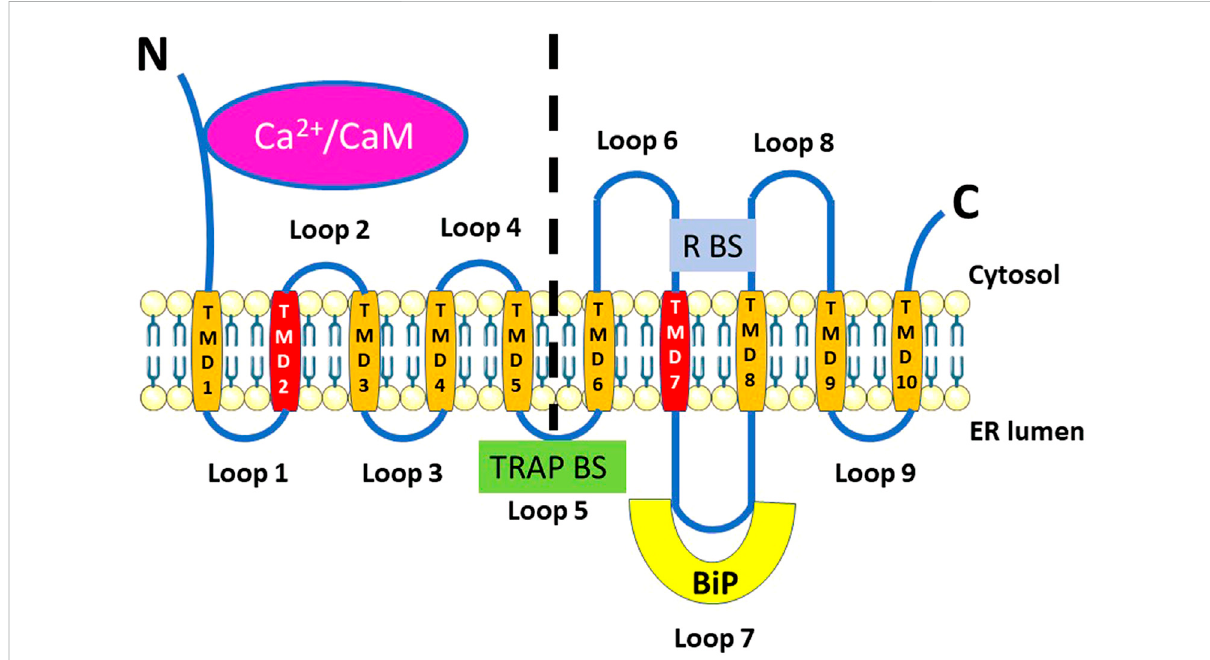
FIGURE 1 Structure of Sec61 α , highlighting elements relevant for its function as ER Ca 2+ -leak channel. Sec61 α is characterized by having 10 transmembranedomains (TMD1-10, inorange)arrangedin two pseudo-symmetrical N- and C-terminal halves (delineated by thevertical dashed line) with both the N and C termini located in the cytosol. The two sterically adjacent TMD2 and TMD7 (in dark orange) form the lateral gate. The interaction of Ca 2+ /calmodulin (Ca 2+ /CaM) at the N-terminus and of BiP at loop 7 is shown. In addition, the luminal binding site for the translocon-associated protein complex (TRAP BS)on loop 5, at theinterphase between theN- and C-terminal halves, and ofthe ribosome (R BS) on loops 6 and 8 are